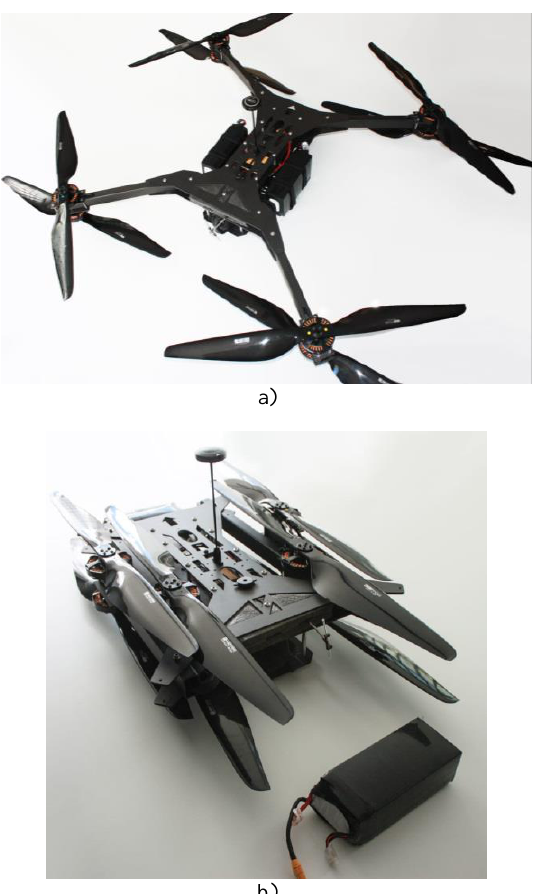
Fig. 7. View of the drone a) deployed, b) retracted